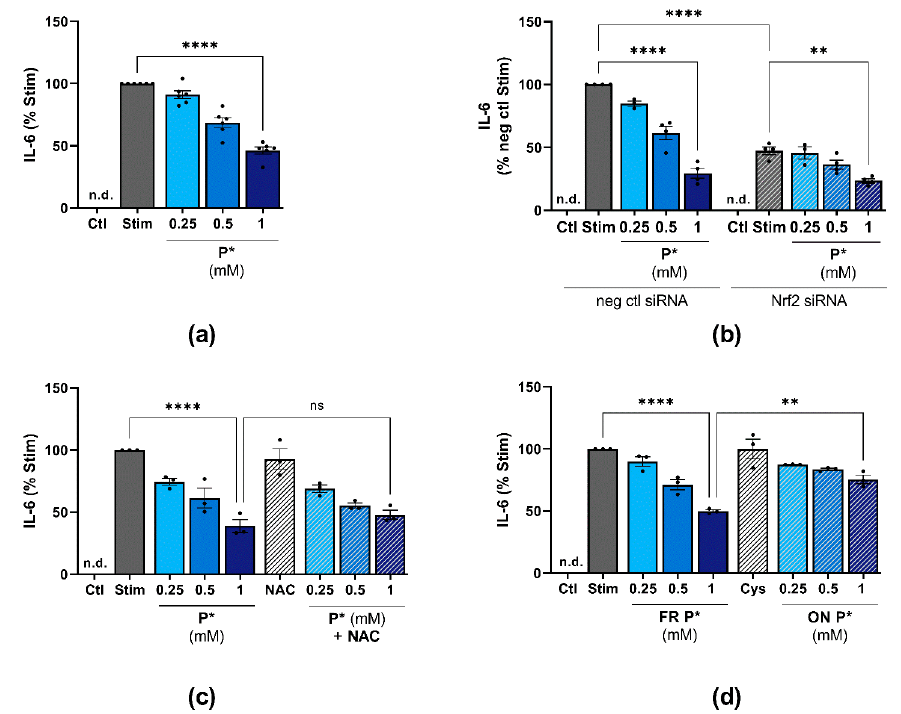
Figure 8. P*-mediated HO-1 induction and H 2 S release affect IL-1 β /IFN- γ -induced IL-6 levels. IL-6 levels were determined by ELISA and normalized against stimulated cells (Stim) set to 100%. Ctl = untreated cells, n.d. = non-detected, ns = not significant. ( a ) ATDC5 cells were pre-incubated with indicated concentrations of P* for 6 h. Afterwards, P* was removed through medium exchange and cells were stimulated for 24 h with IL-1 β /IFN- γ . n = 5, **** p < 0.0001. ( b ) ATDC5 cells transfected with Nrf2 (Nrf2 siRNA) or negative control (neg ctl siRNA) siRNA were preincubated with P* for 6 h, followed by a medium exchange and 24 h of stimulation with IL-1 β /IFN- γ . n = 4, ** p < 0.01, **** p < 0.0001. ( c ) ATDC5 cells were treated with 2 mM N-acetylcysteine (NAC) for 1 h and subsequently with P* for 6 h. The medium was exchanged, and the cells were stimulated for 24 h with IL-1 β /IFN- γ . n = 3, **** p < 0.0001. ( d ) P* was decomposed leaving solutions uncapped overnight (ON) at 37 °C in the presence of L -cysteine (1:1, ON Cys). The next day, ATDC5 cells were pre-incubated for 6 h with either freshly prepared P* or decomposed P* (ON P*) before the medium was exchanged followed by 24 h of stimulation with IL-1 β /IFN- γ . n = 3, ** p < 0.01, **** p < 0.0001.